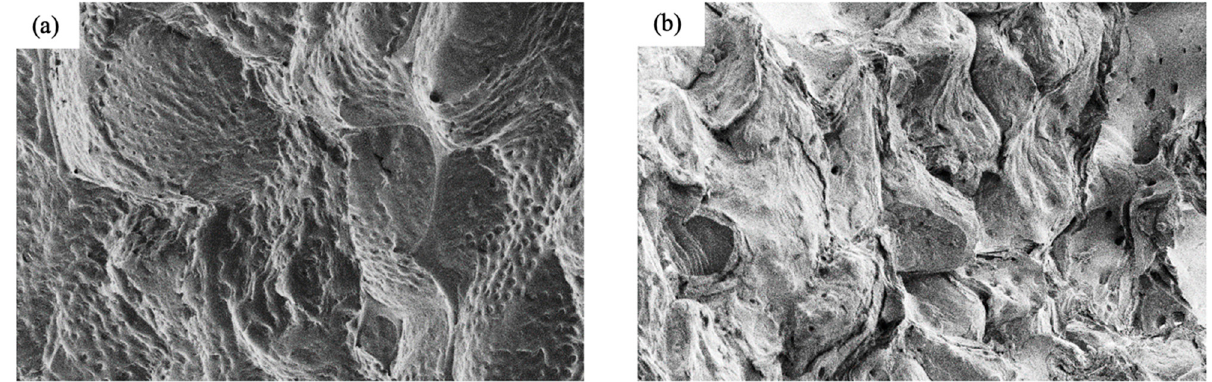
Figure 2. SEM images of plum fillers: ( a ) unmodified; ( b ) silanized.